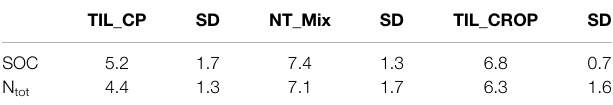
TABLE 7 | Sediment enrichment ratio for carbon (SOC) and nitrogen (N tot ) in surface runoff samples ( n = 4, SD = standard